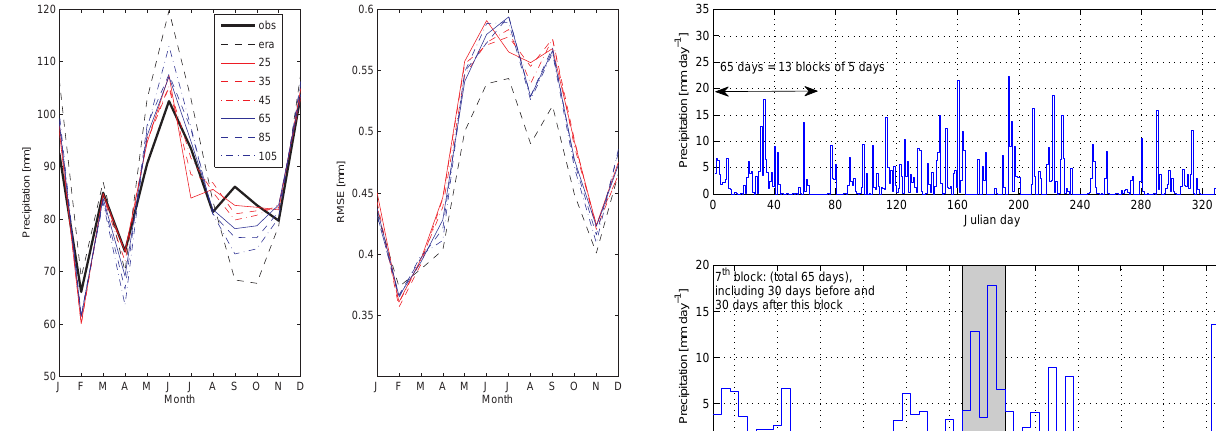
Fig. 2. Left: Average monthly precipitation sums for various block lengths. “obs” denotes the observed precipitation, while “era” de- notes the uncorrected ERA15/REMO precipitation. The sensitivi- ties are shown for block lengths of 25, 35, 45, 65, 85 and 105 days. Right: RMSEs of daily precipitation differences for various block lengths.